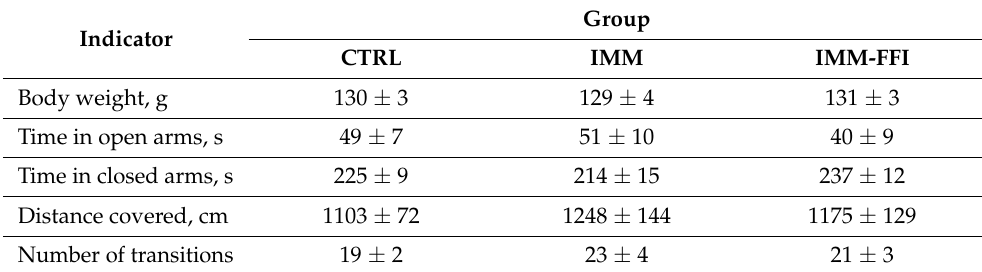
Table 1. Group formation according to the EPM test and body weight of rats.